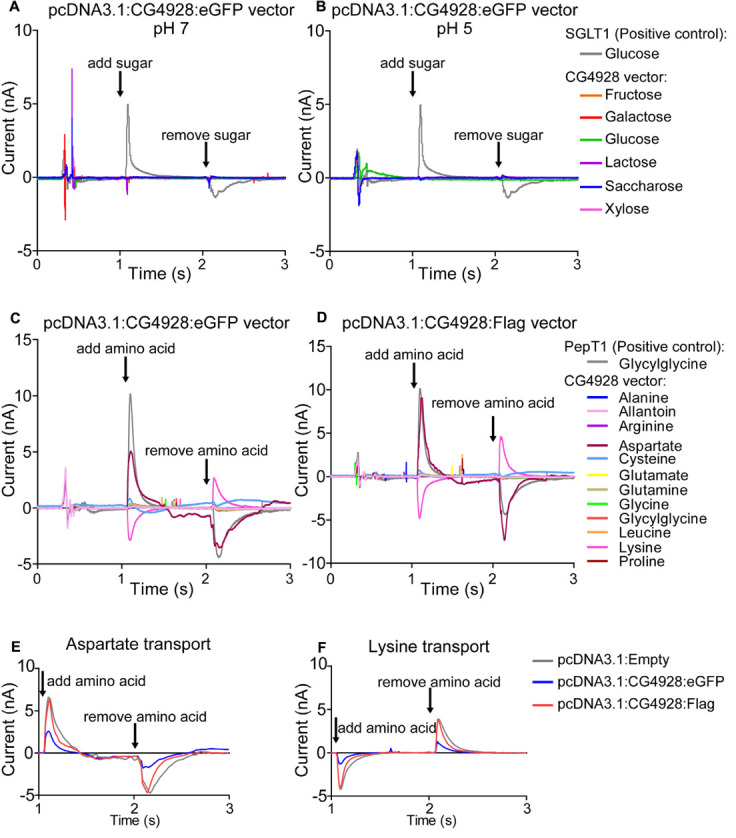
CG4928 as a transporter. To further study the function of CG4928, HEK293T cells were transfected with CG4928:eGFP, CG4928:Flag, and control (empty) vectors. The substrate profile was investigated on isolated membranes expressing the vectors using SSM-based electrophysiology (Bazzone et al., 2017). Six different sugars and 12 amino acids and peptides were tested. SGLT1 and PepT1 were used as positive controls. CG4928:eGFP-transfected cells did not transport any sugars at (A) pH 7 or (B) pH 5. Both (C) CG4928:eGFP- and (D) CG4928:Flag-transfected cells had altered currents for aspartate and lysine. However, when comparing the alteration in current to the empty vector, no differences were observed for (E) aspartate or (F) lysine.